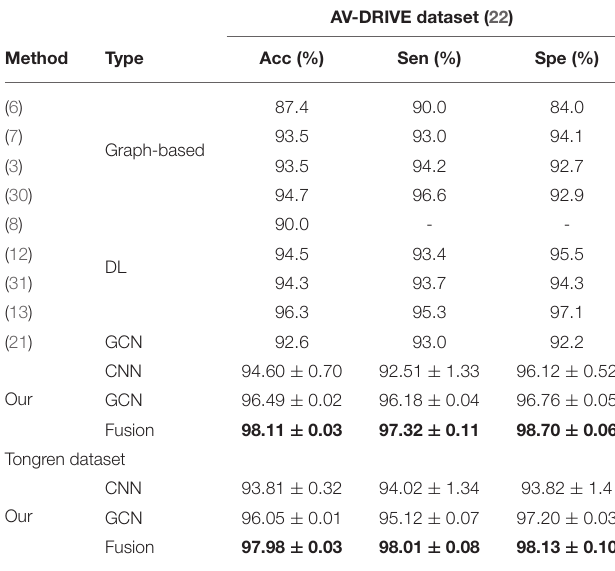
TABLE 1 | A/V classification results on the AV-DRIVE and Tongren